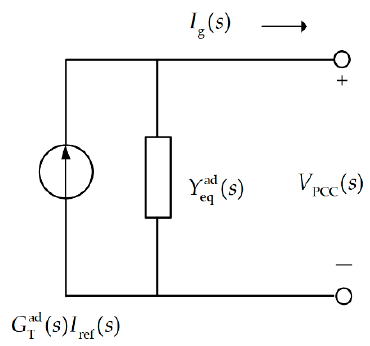
Figure 3. Equivalent current source model of the inverter.